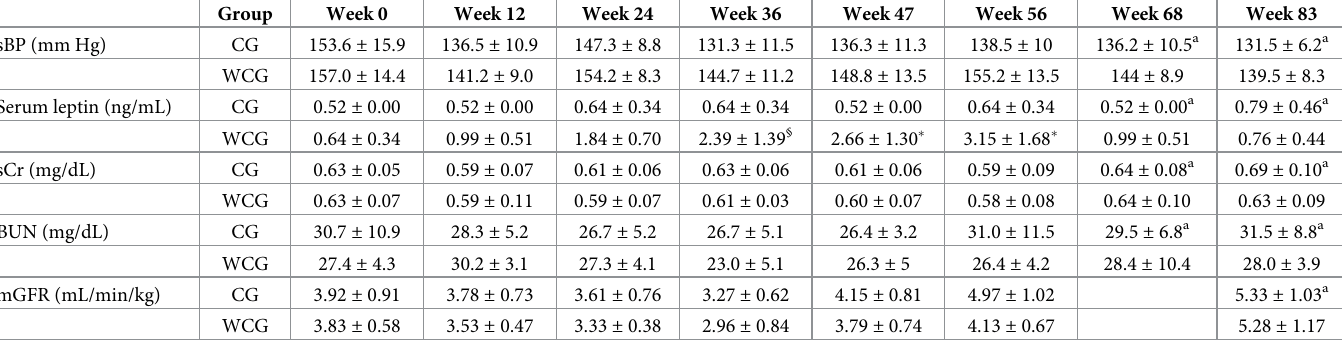
Table 1. Systolic blood pressure (sBP), serum leptin, serum creatinine (sCr), blood urea nitrogen (BUN) and glomerular filtration rate (mGFR) measured by exo- iohexol plasma clearance over time in the control group (CG) and the weight-change group (WCG) in dogs.